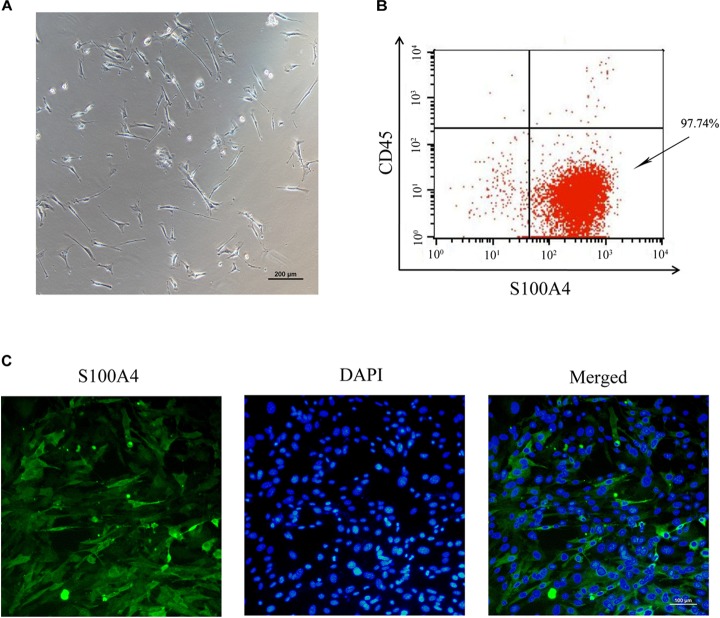
Culture and identification of TSCs. (A) The morphology of TSCs at passage 3 observed by optical microscope. (B) Flow cytometric analysis showed that nearly all the three-passage TSCs were CD45-S100A4+. (C) Immunofluorescence staining was imaged using anti-S100A4 (green), and the nuclei were counterstained with DAPI (blue).